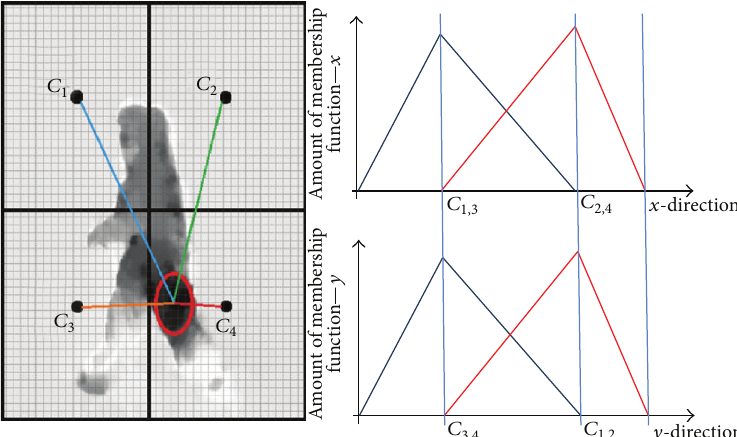
Figure 3: The result of dorsal processing stream applying optical flow [26] and the optical flow division into the fuzzification has been depicted. The resolution of divisions is designed for categorization of actions group to have additional interference of dorsal and ventral processing streams. It can be a good representative of the interaction on MT, middle temporal of dorsal stream, and V4, ventral stream (for shape and orientation), or the MST area with inferior temporal (IT) (see more details in [14, 15]). The membership function of the action will be estimated from the position of maximum flow in the flow image. Membership values are aggregated through the proposed technique to increase the robustness. The input image of action mentioned in the figures is obtained from KTH human action recognition dataset [39].